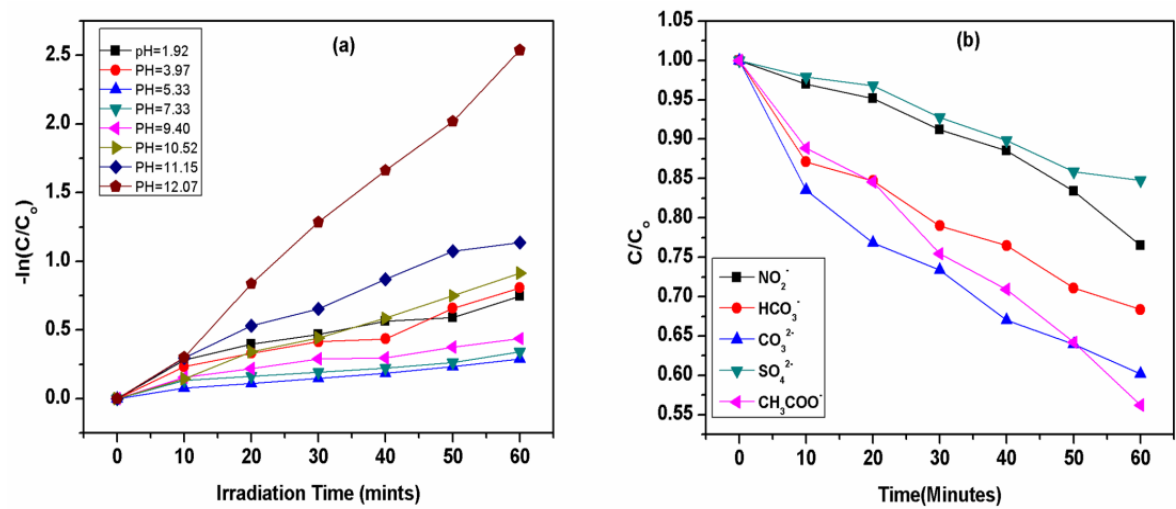
Figure 3. Effect of different ( a ) pH on degradation of crystal violet ( b ). inorganic anions (NO 2 − , CO 3 2− , HCO 3 − , SO 4 2−, CH 3 COO − ) on the removal efficiency of CV by UV/PMS at [CV] ₒ = 0.01 mM,